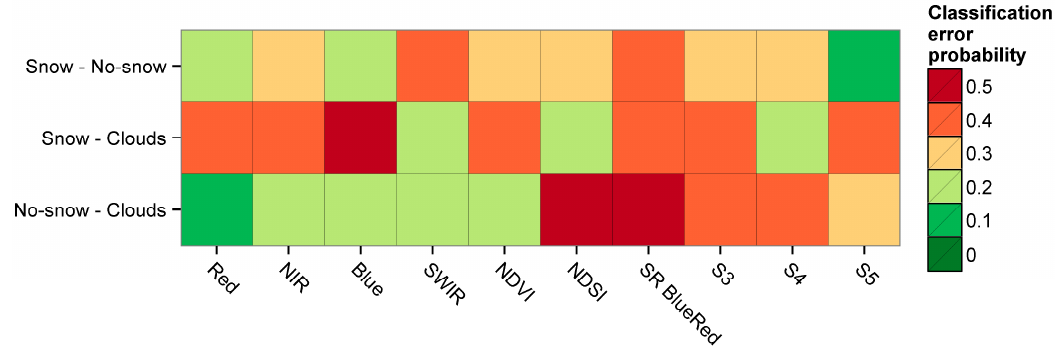
Figure 9. Probability of misclassification (classification error) of major classification classes for different indices of separation. Red, Near InfraRed (NIR), Blue and Short Wave InfraRed (SWIR) correspond to the four bands of PROBA-V, Normalized Difference Vegetation Index (NDVI) and Normalized Difference Snow Index (NDSI) are the two indices used in our classification, simple Ratio (SR) BlueRed is the index used in Sentinel-2 snow classification (Figure 1) and S3 to S5 are indices used in the PROBA-V snow quality flag (Table 1).